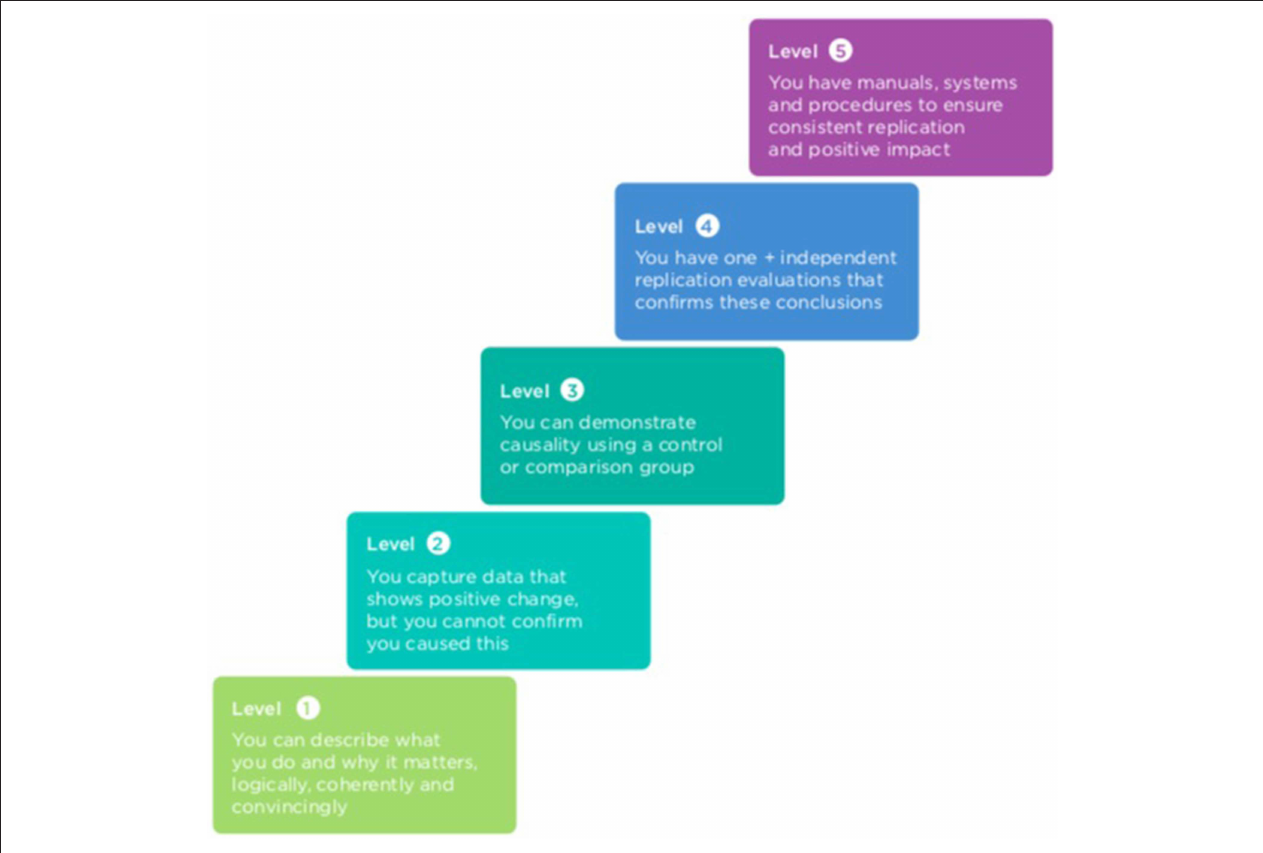
FIGURE 2 | Standards of evidence by